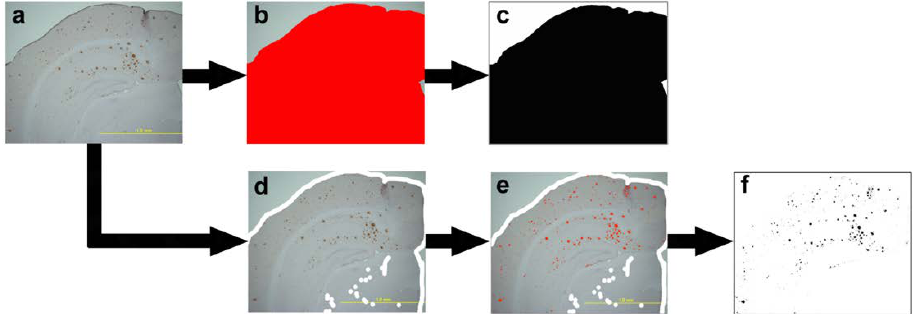
Scheme A1. Semi-automatic measurement of senile plaques in the regions of interest (cortex and the hippocampus). Upper line: Measurement of the area of the section: (1) Filling of the section ( a ) with red color ( b ); (2) dichotomization of color into black and white using a semiautomatic method with an appropriate color threshold ( c ). Lower line: Measurement of the total area of the senile plaque: (1) digital stripping of A β -stained lesions located out of the regions of interest ( d ); (2) change of color of the remaining A β -stained area to red using manual calibration with an appropriate color threshold ( e ); (3) dichotomization of color to black (A β -stained lesions in regions of interest) and white (other) using a semiautomatic method with an appropriate color threshold ( f ).